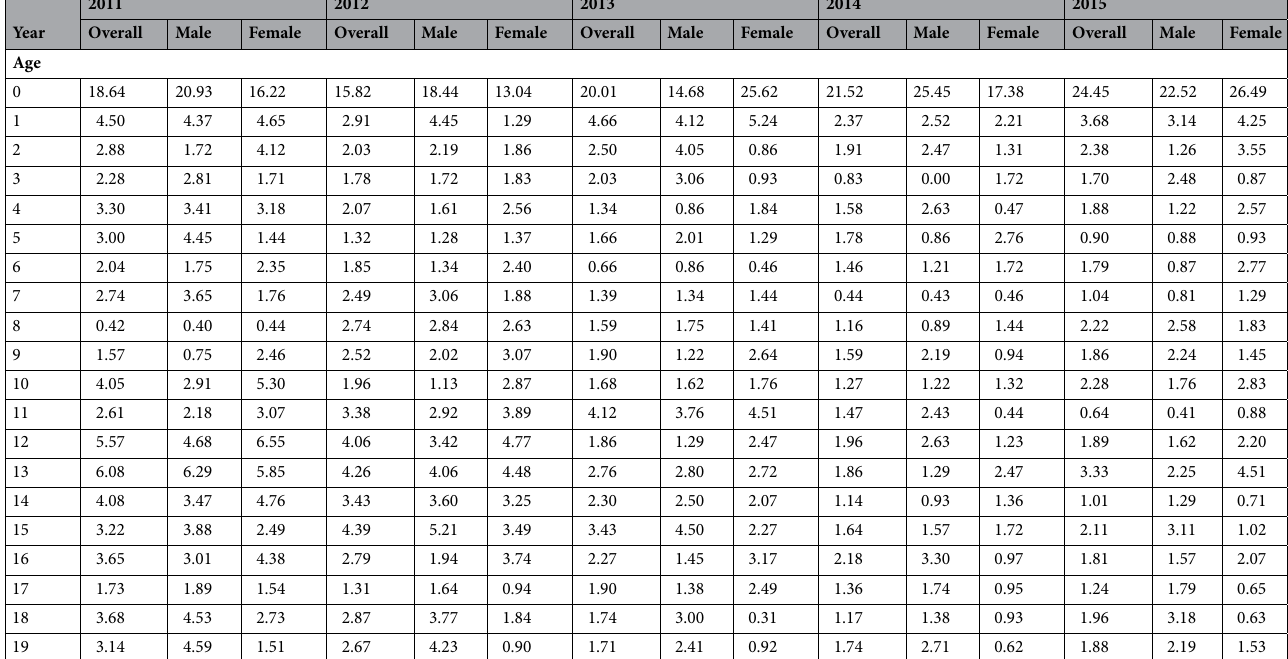
Table 2. Sex-specific and age-specific annual incidence rate of congenital scoliosis for 5 years (2011–2015). *Annual incidences are represented in terms of the number per 100,000 persons. *Korean Statistical Information Service (KOSIS; http://kosis .kr) data was used to determine the total population according to age during the study period, allowing the calculation of sex-specific and age-matched annual incidences.